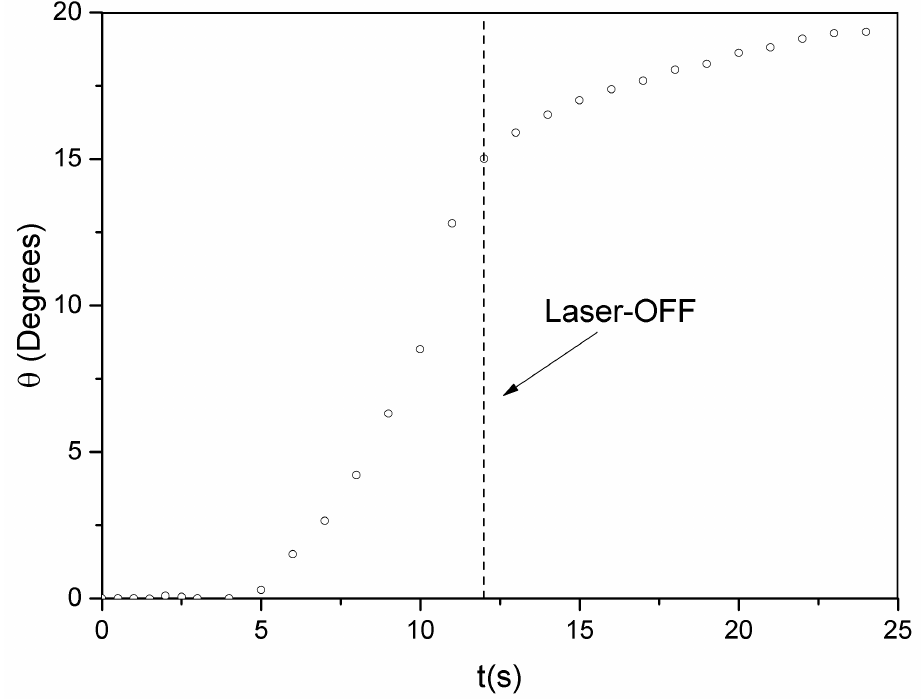
Figure 6. Angular displacement (Degs) as a function of time (s) for the black colored PVC tape when illuminated by the red laser at λ = 650 nm. The dashed line indicates the point at which the red laser is switched